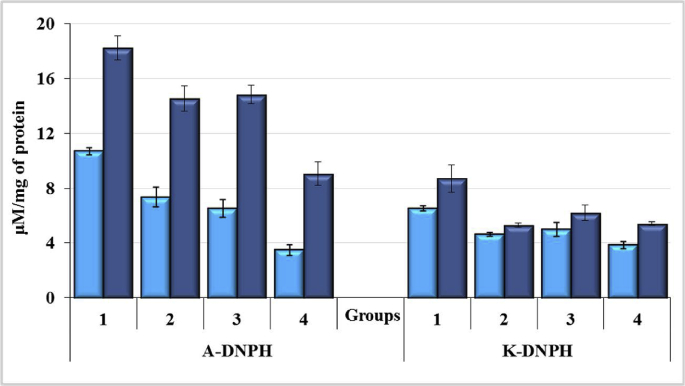
The level of oxidative modification (spontaneous Image 1 and induced Image 2 levels) of blood plasma proteins in rats exposed to CCl4 with or without enterosorption using AC1 and AC2 formulations, p < 0.05.